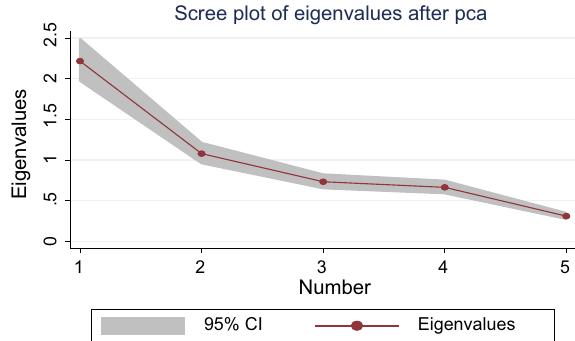
Fig. 1 Scree plot for the principal component analysis (PCA). Source : Authors computations, 2022